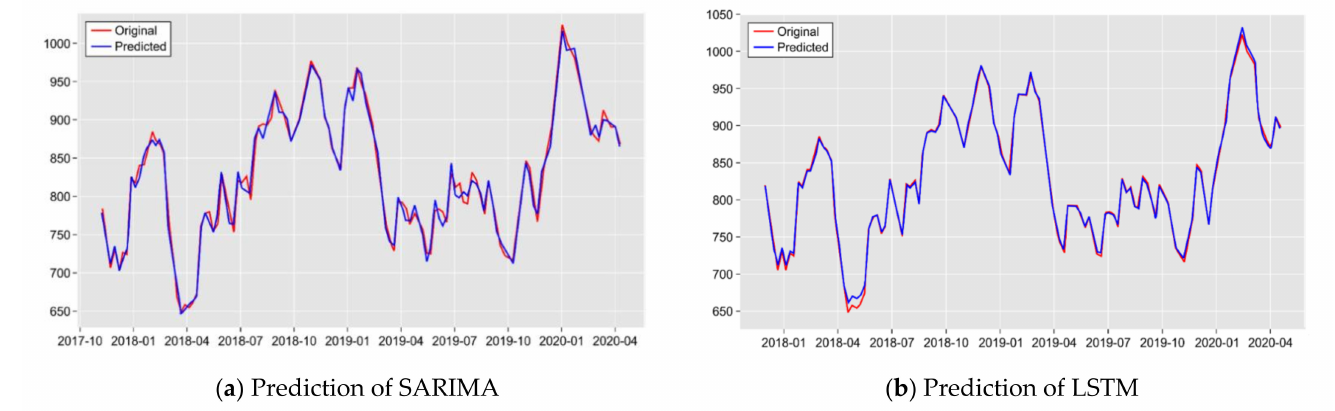
Figure 4. Plots of ( a ) SARIMA and ( b ) LSTM prediction results for comprehensive